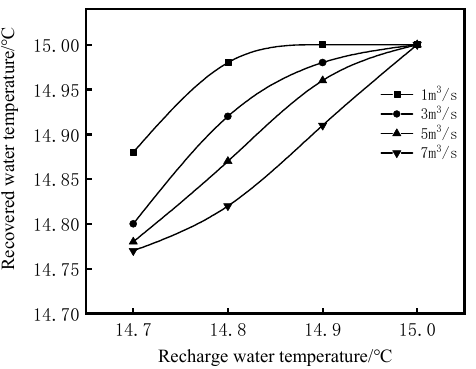
Figure 14. Variation of temperature at observation point of recharge well with time.